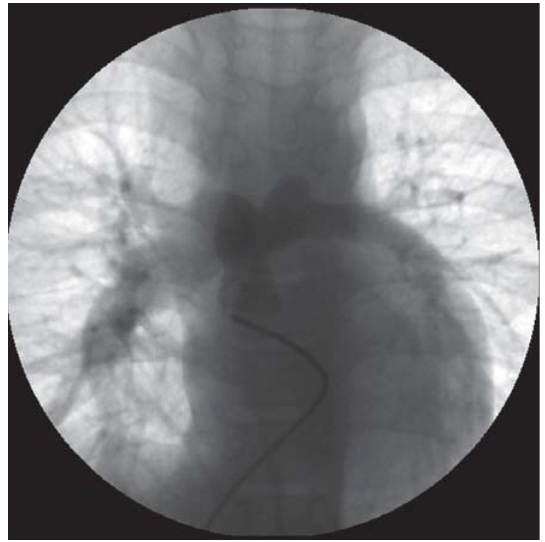
Fig. 2 – Estudo hemodinâmico demonstrando o posicionamento e